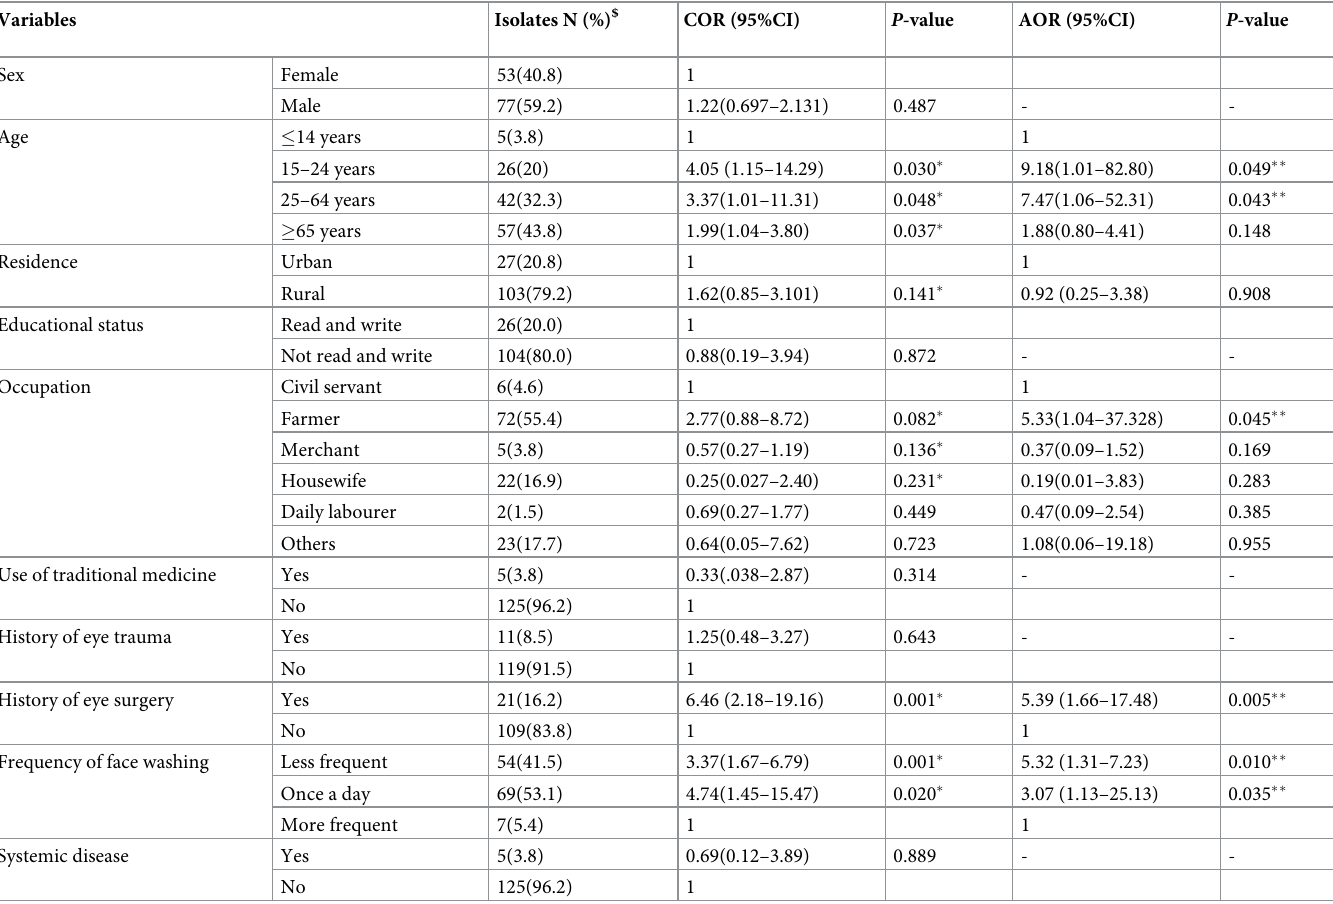
Table 6. Association of socio-demographic and clinical factors with bacterial isolates in EOI patients at DMCSH, Northwest Ethiopia, 2021.